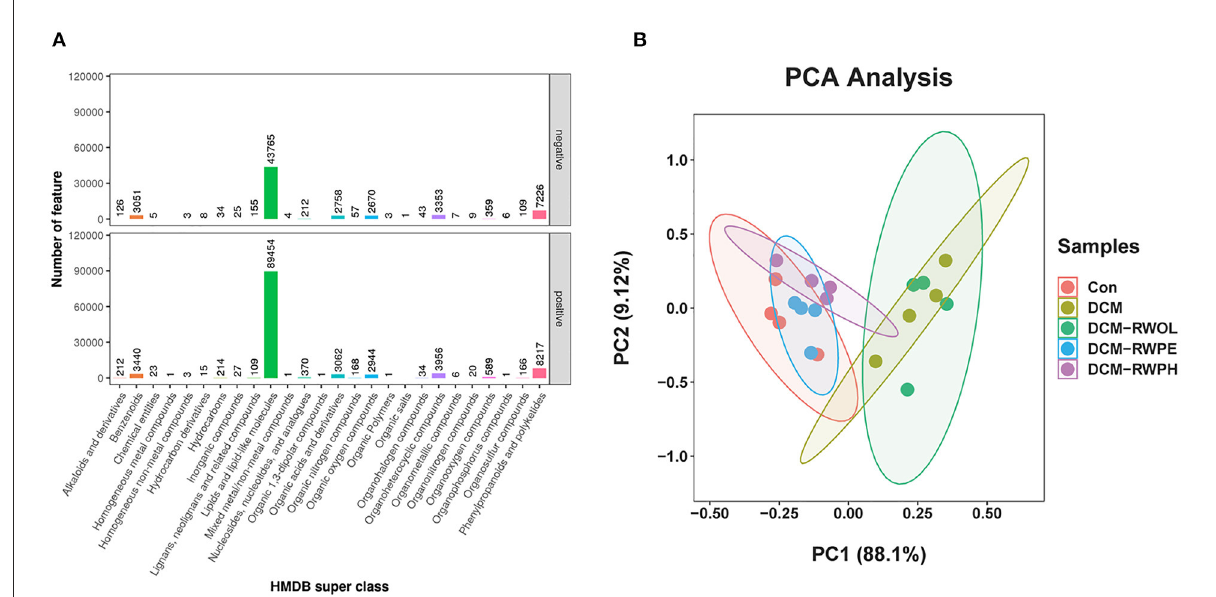
FIGURE8 RWPH and RWPE modulated the gut microbiota metabolites in DCM mice. (A) Human Metabolome Database (HMDB) super class identification classification and annotation diagram of first-level metabolites. (B) Principal component analysis (PCA) analysis of metabolites for 5